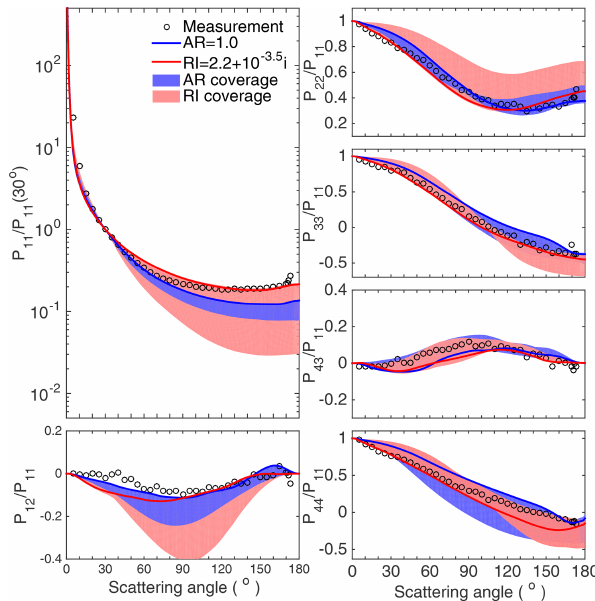
Figure 9. Comparison between the simulated results of the scatter- ing matrix elements of the Lokon volcanic ash samples with differ- ent variable parameters, including coverage with the AR as the vari- able (shaded blue area), coverage with the RI as the variable (shaded red area), optimal case for the two variable parameters (blue and red lines), and the measurement given by the AGLSD (black hallow